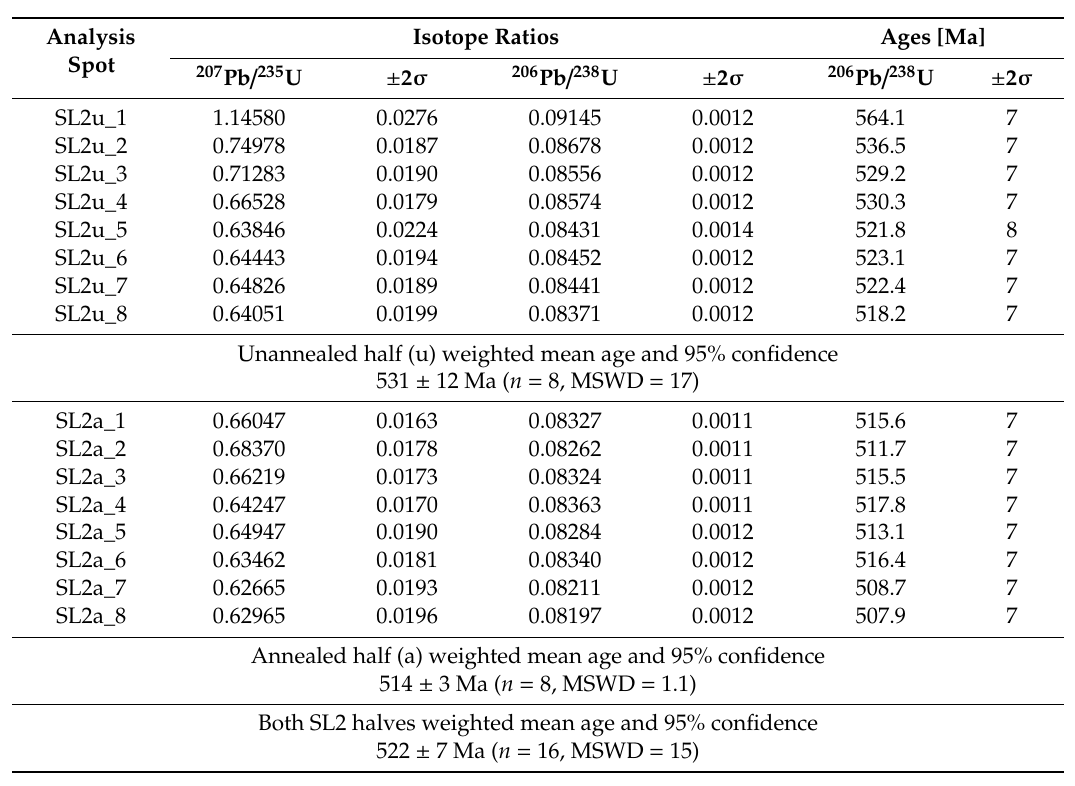
Table A4. U-Pb isotope ratios and 206 Pb / 238 U ages of the large, heterogeneous Sri Lankan zircon crystal SL2 with multiple analyses spots on both, the radiation damage-a ff ected unannealed half (u) and the heat-treated, annealed half (a) with its crystallinity